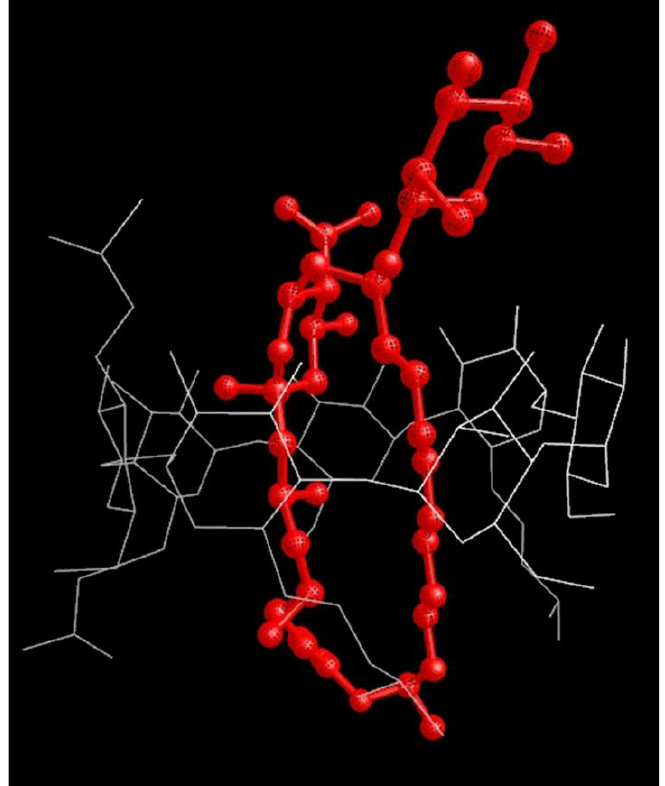
Figure 5. Optimized molecular mechanics model of the natamycin complex with HPβCD. Red lines represent natamycin and white lines represent HPβCD.